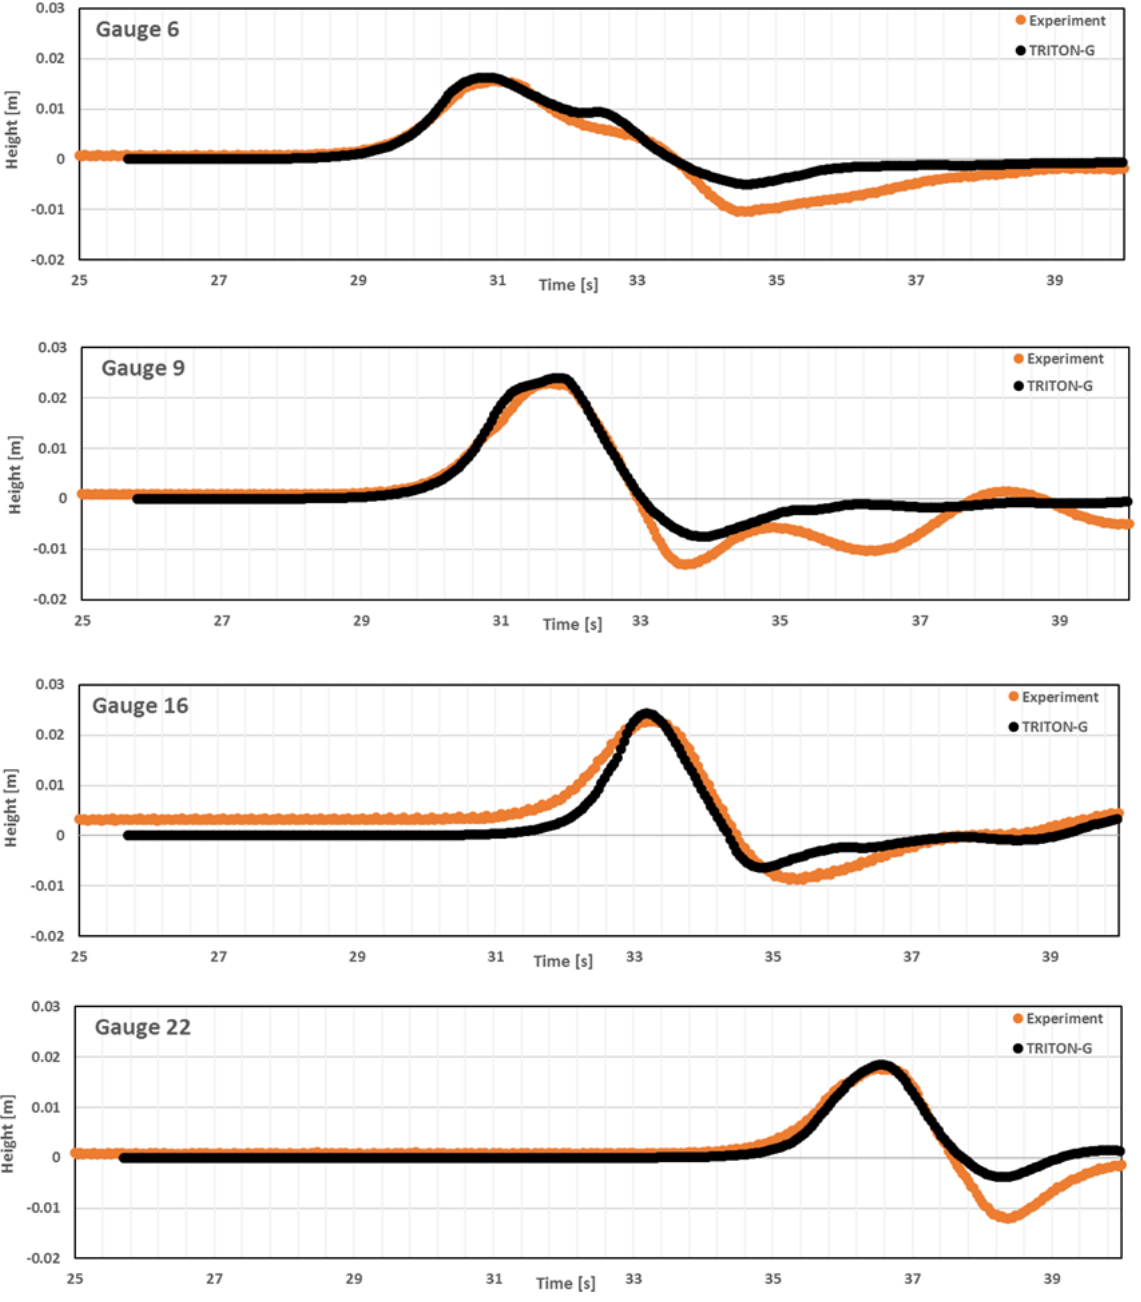
Figure A7. Comparison between computed and measured water levels at gauges 6, 9, 16 and 22 for case A ( H = 0 .